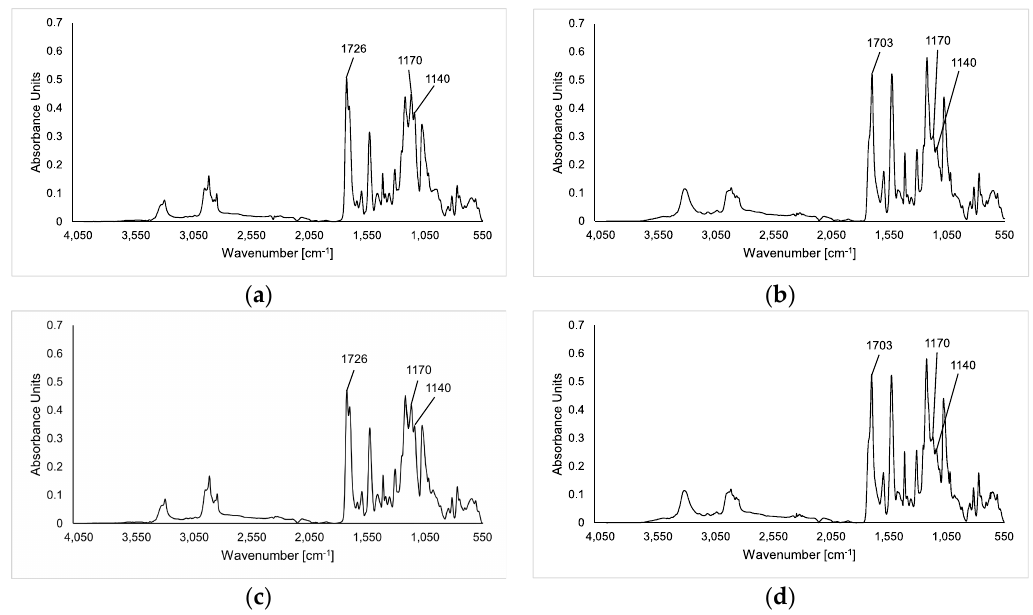
Figure 3. FTIR spectra of ( a , b ) Elastollan B85A-10 and ( c , d ) Elastollan C85A-10: ( a , c ) negative control samples without enzyme and ( b , d ) following hydrolysis by TfCut2 at 60 °C for 100 h. GPC analysis revealed a significant decrease of up to 19% of the weight-averaged molecular weights ( M w ) and of up to 21% of the peak molecular weights ( M p ) of Elastollan B85A-10 and C85A-10 hydrolyzed by LCC compared to the negative control samples without enzyme (Table 3). The number-averaged molecular weight ( M n ) of both Elsatollans did not change following incubations with the enzymes since the large proportion of bulk polymer inside the TPU cubes was not